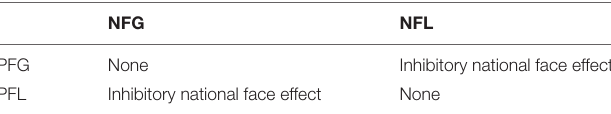
TABLE 5 | Mechanism of national face and personal face in non-conflict vs. conflict conditions.